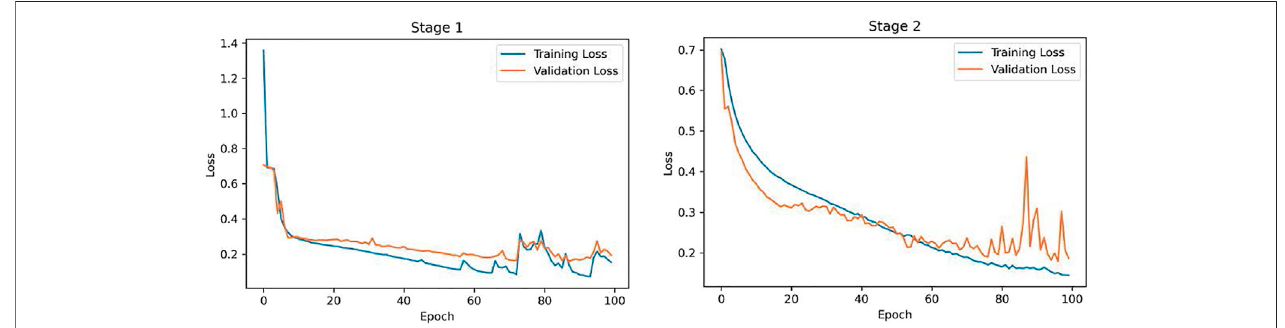
FIGURE 6 | Training and Validation loss curves obtained for the COVID-FACT stage one and stage two.